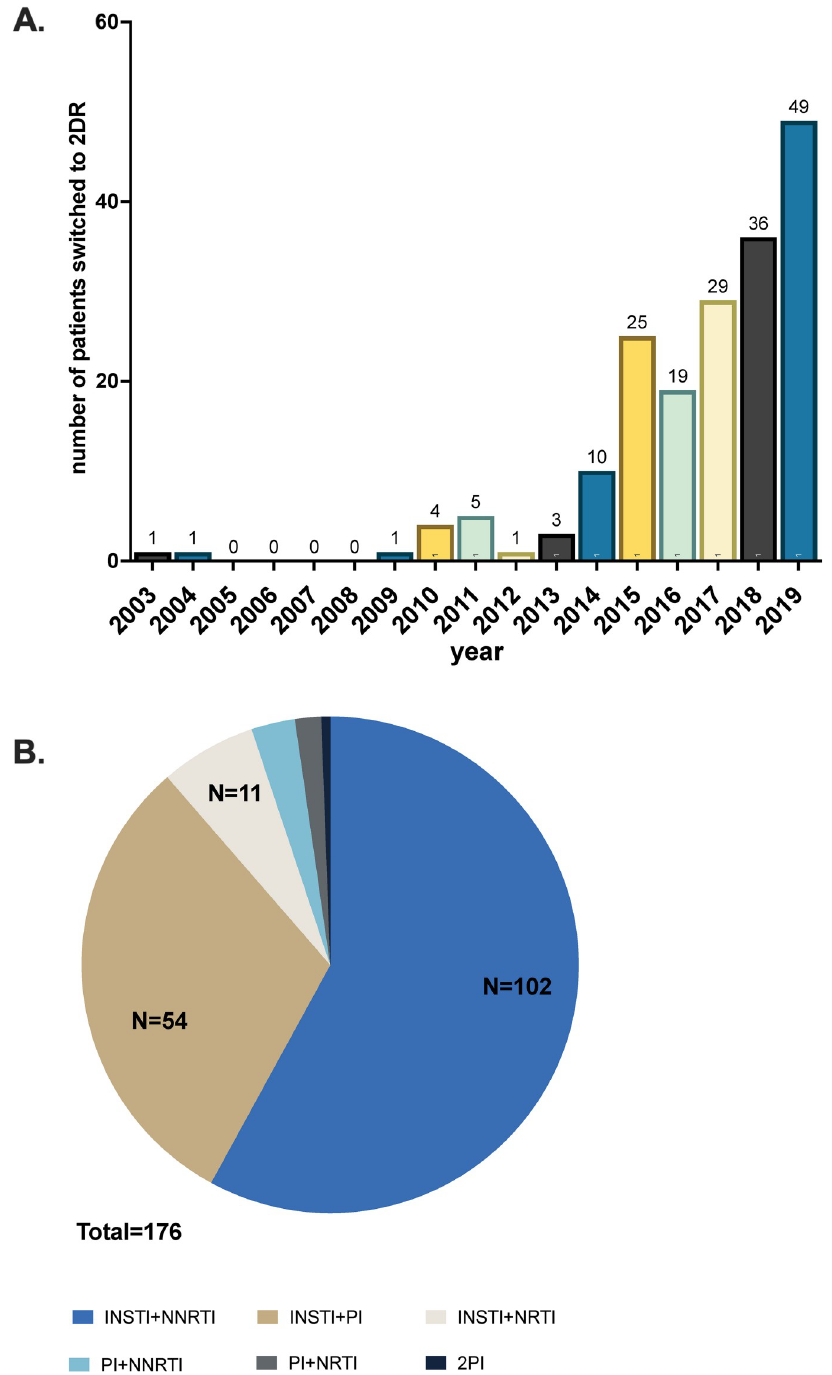
Fig 1. 2DR initiation. A: Yearly number of patients that started/ switched to treatment with dual therapy. B: Dual regimens used by class. INSTI- integrase inhibitor, NNRTI- non nucleoside analog reverse transcriptase inhibitor, PI- protease inhibitor, NRTI- nucleoside analog reverse transcriptase inhibitor.